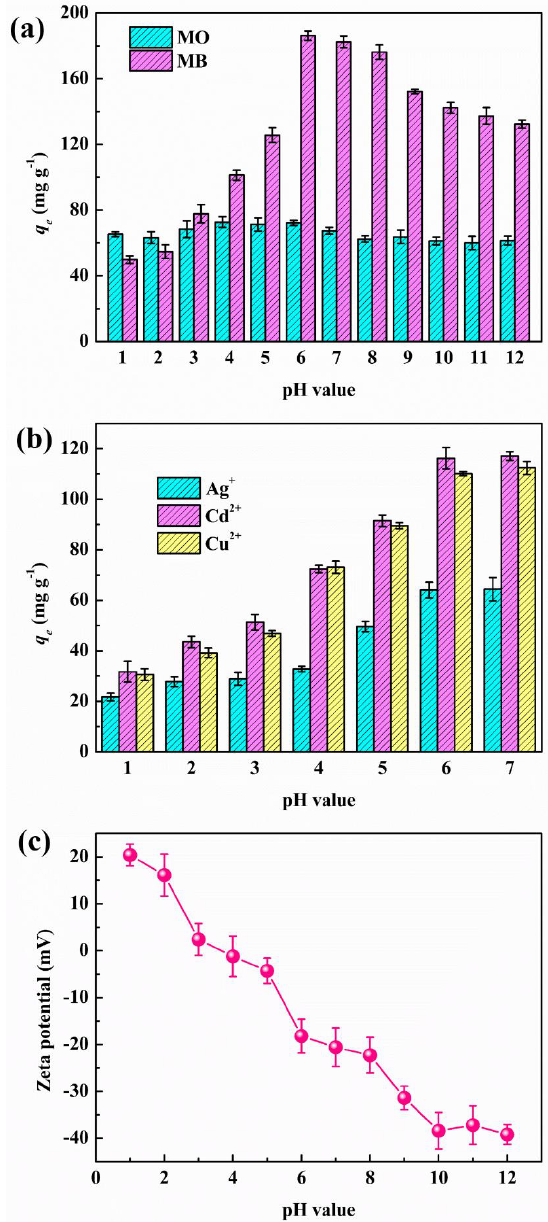
Figure 8. Effects of pH on dyes ( a ) and heavy metals ( b ) over MoS 2 NS, and the Zeta potential ( c ) of MoS 2 NS at different pH values. For dyes: 20 mg L −1 of the initial concentration, for heavy metals: 15 mg L −1 of the initial concentration.